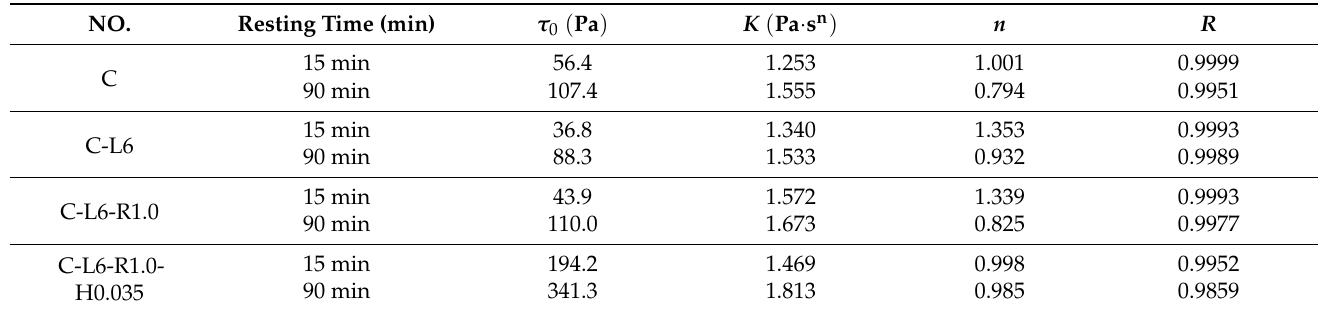
Table 11. Rheological parameters of C-L6-RPP-HPMC pastes.